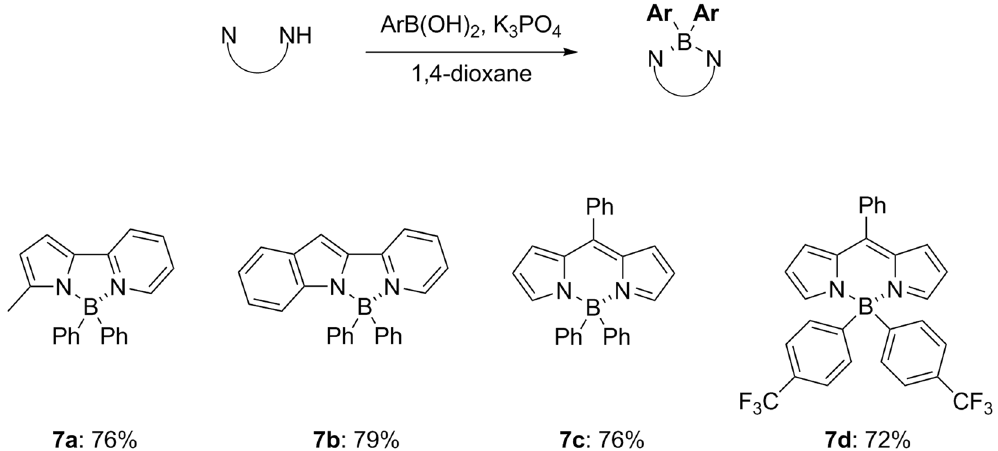
Figure 8. Reaction scope for organoborons from N,N -bidentate ligands. Conditions: N,N -ligand (1.0 mmol), boronic acid (9.0 equiv), K 3 PO 4 (3.0 equiv) in 1,4-dioxane (0.02 M) at 110 °C with stirring for 20